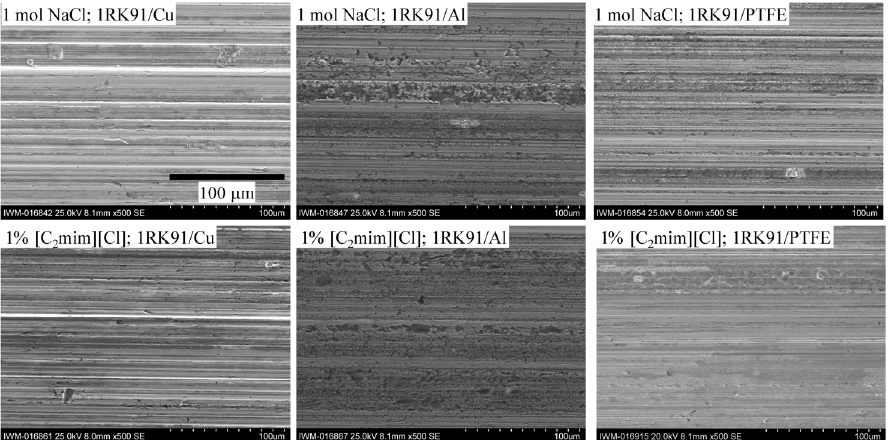
Fig. 6 Wear analysis of the 1RK91 disks using scanning-electron-microscope after tribotest (10 N, 20 Hz, RT, 1 mm, 1 h) at different